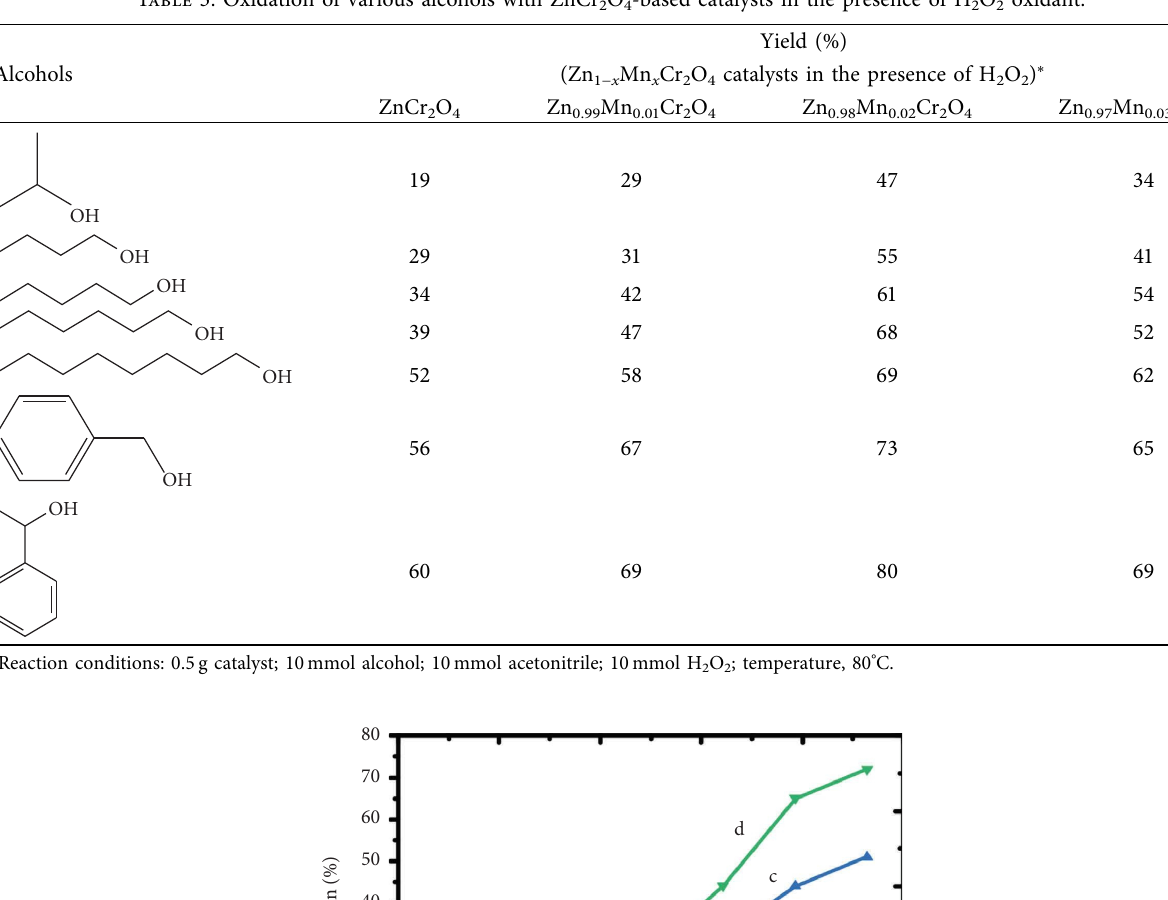
2 O 4 -based catalysts in the presence of H 2 O 2 oxidant. Yield (%)